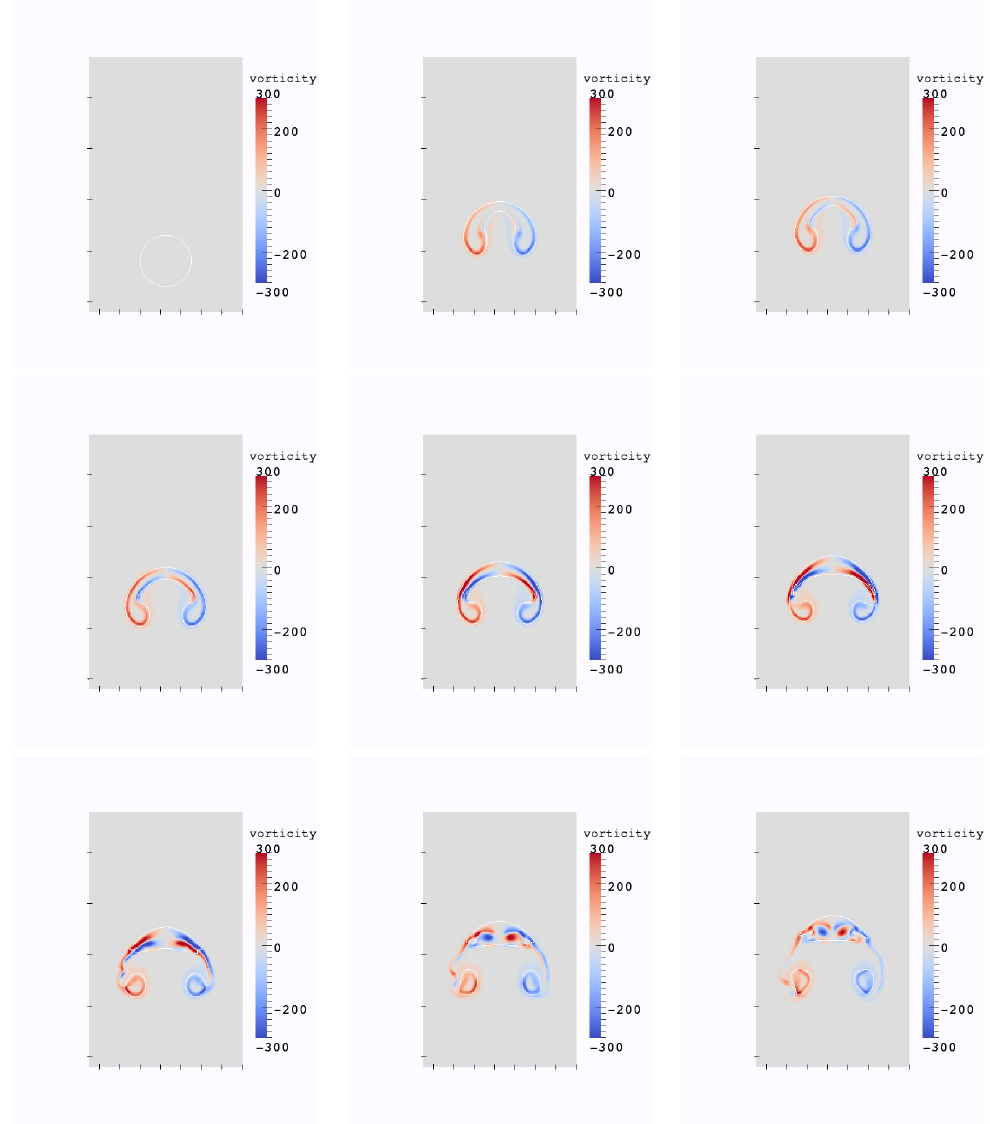
Figure 11. Evolution of the interface and vorticity values for the bubble test case from [36] at non-dimensional times (cid:112) − t ∗ g /0.025 = 0.,2.8,6,4.,4.4,4.8,5.2,5.6,6., resolution 120 ×